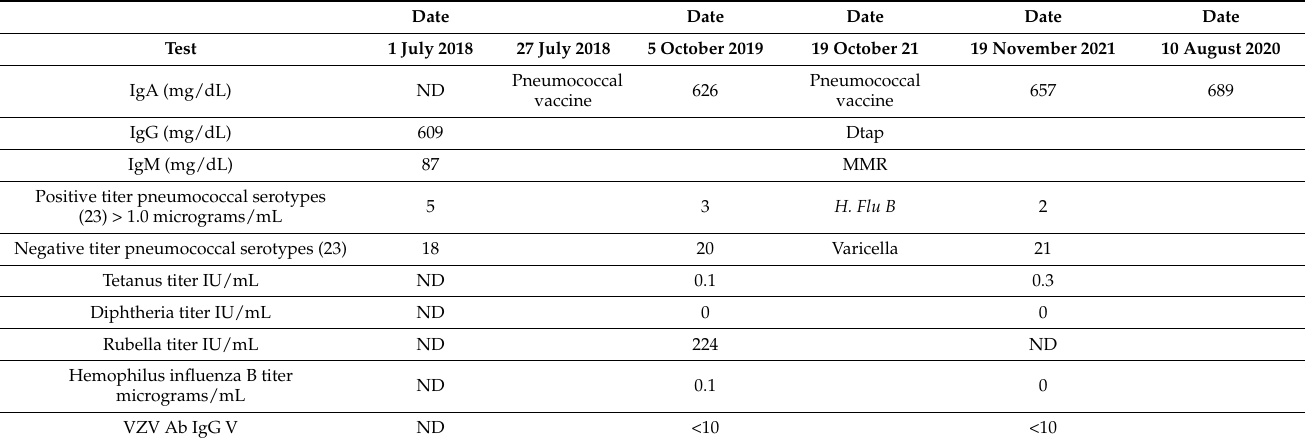
Table 1. Vaccinations and antibody